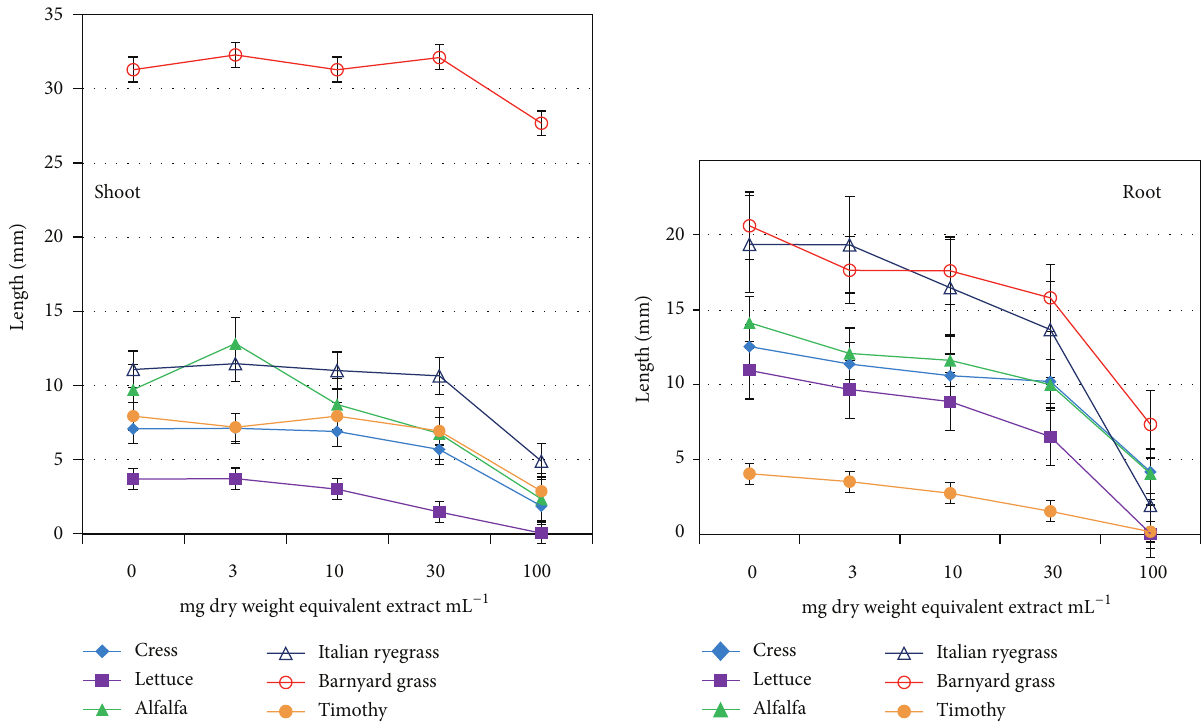
Figure 5: Effect of aqueous methanol extracts of O. tenuiflorum on shoot and root growth of different plant species at four different concentrations. Other details are the same as Figure